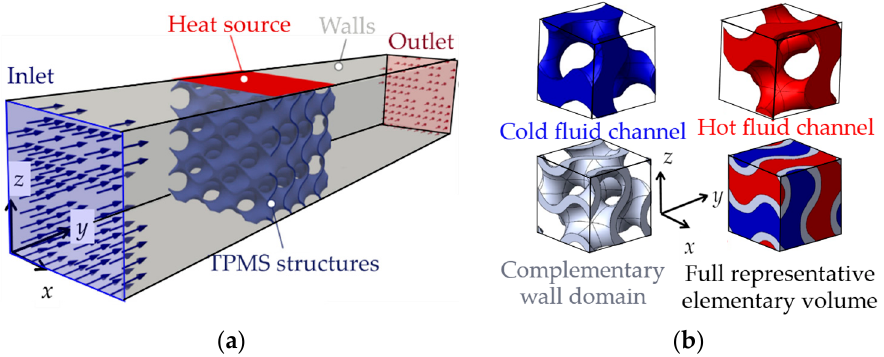
Figure 5. Demonstration of the TPMS structures used in literature: ( a ) Cooling structures for heat sinks [52]; ( b ) Cooling structures to separate cold and hot fluid domains for heat exchangers [54].